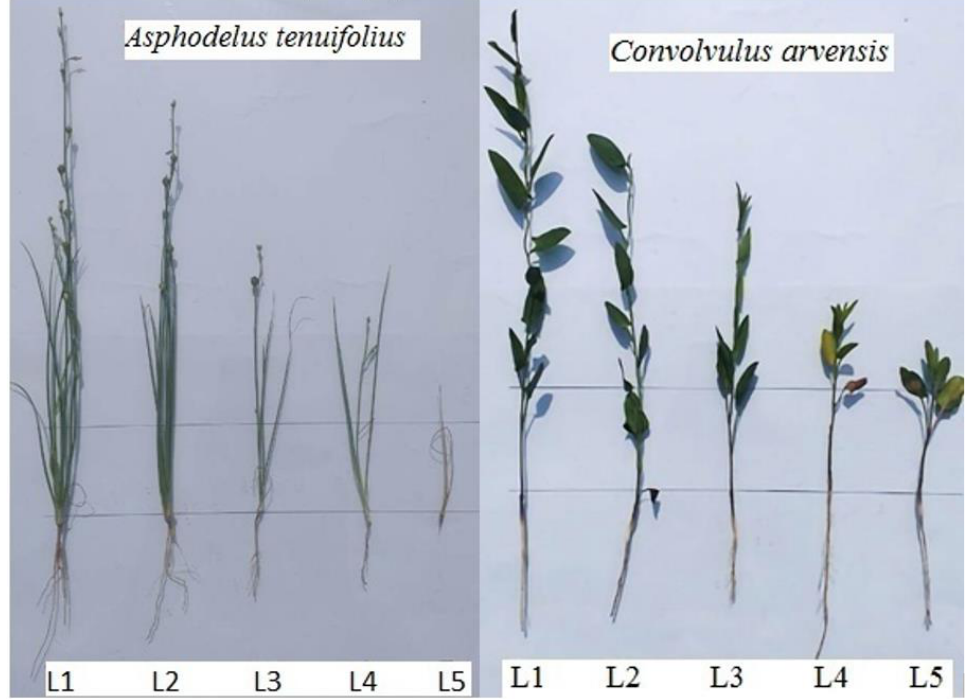
Figure 4. Effect of shoot water extract levels of Trianthema portulacastrum and herbicide (L1 = distilled water; L2 = 30%; L3 = 60%; L4 = 100%; and L5 = herbicide treatment) on the vegetative growth of A. tenuifolius and C. arvensis .